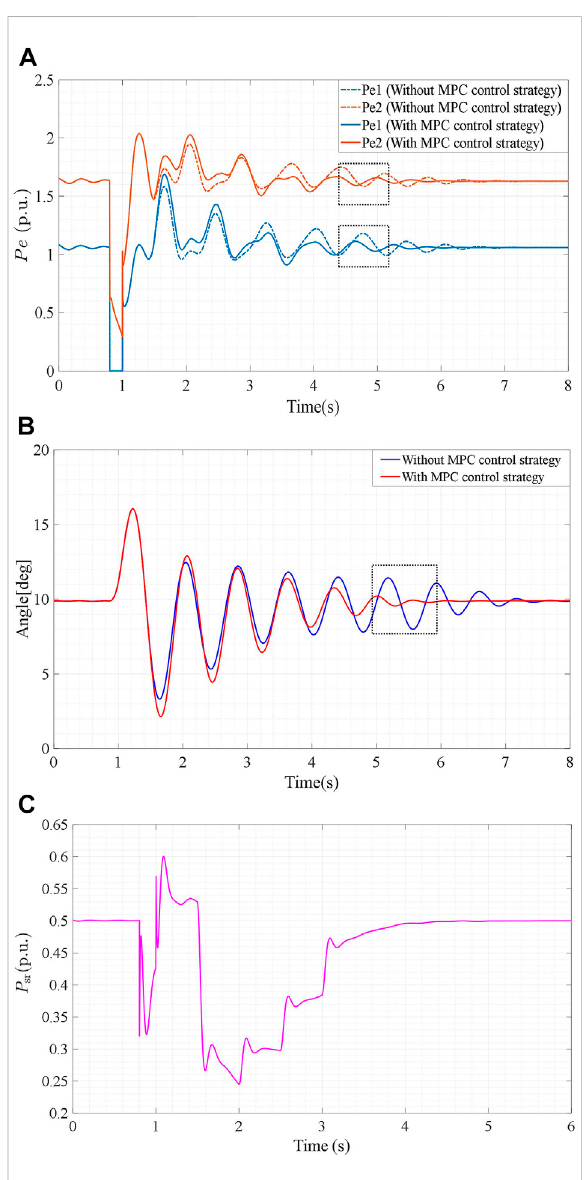
FIGURE 7 (A) : Dynamic performances of the active electromagnetic output powers Pe 1 and Pe 2. (B) : Transient angles of generator 1 δ 1 in the power grid. (C) : Active power output of the PV system.